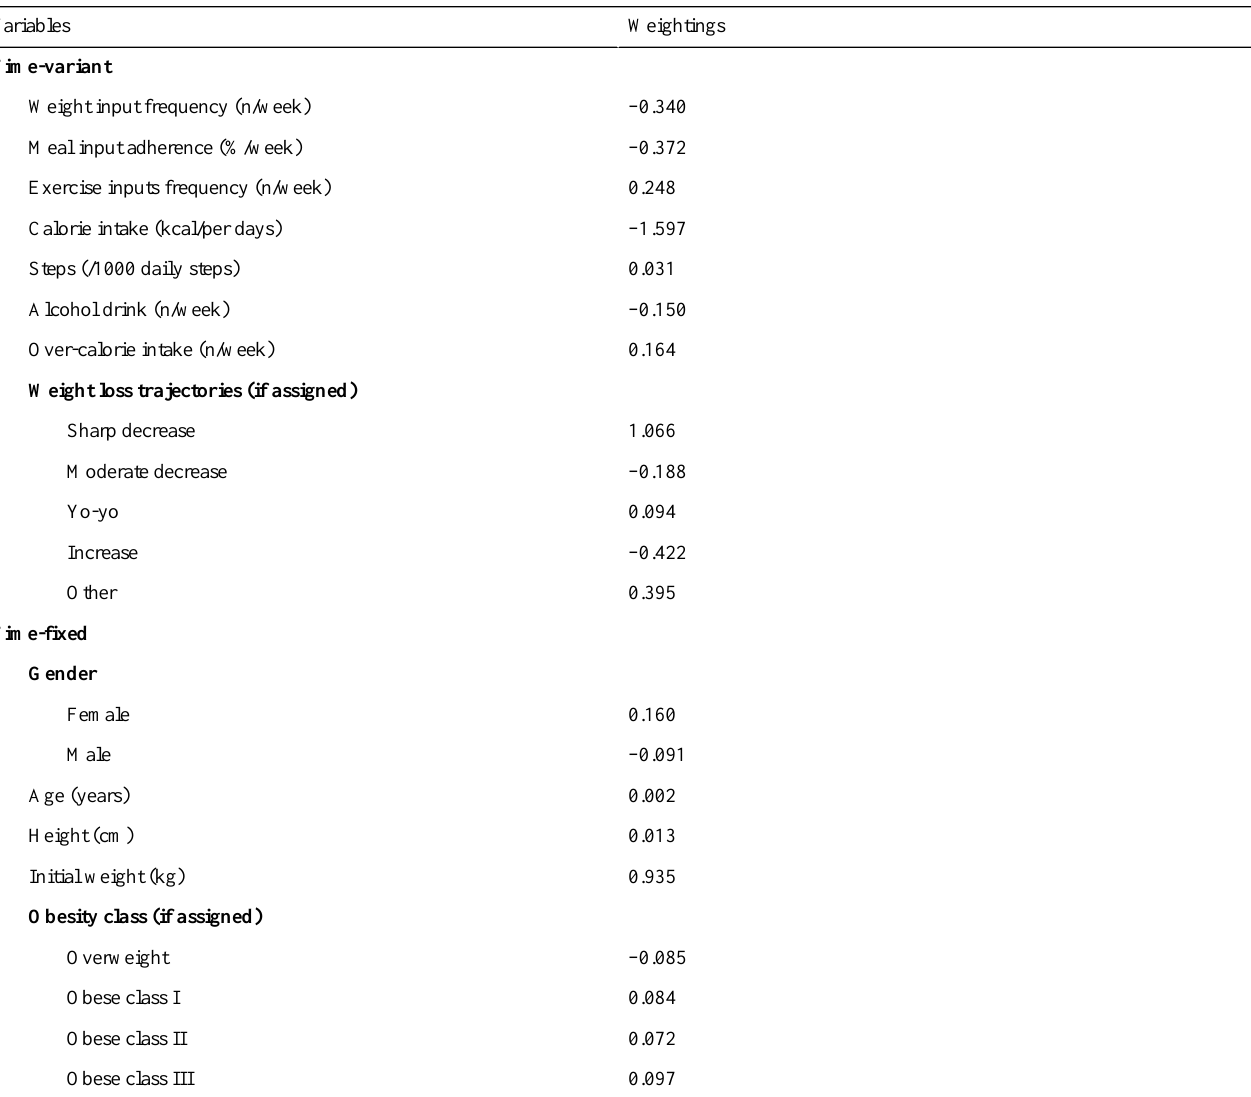
Table 2. Weightings for time-variant and time-fixed variables in matrix w.